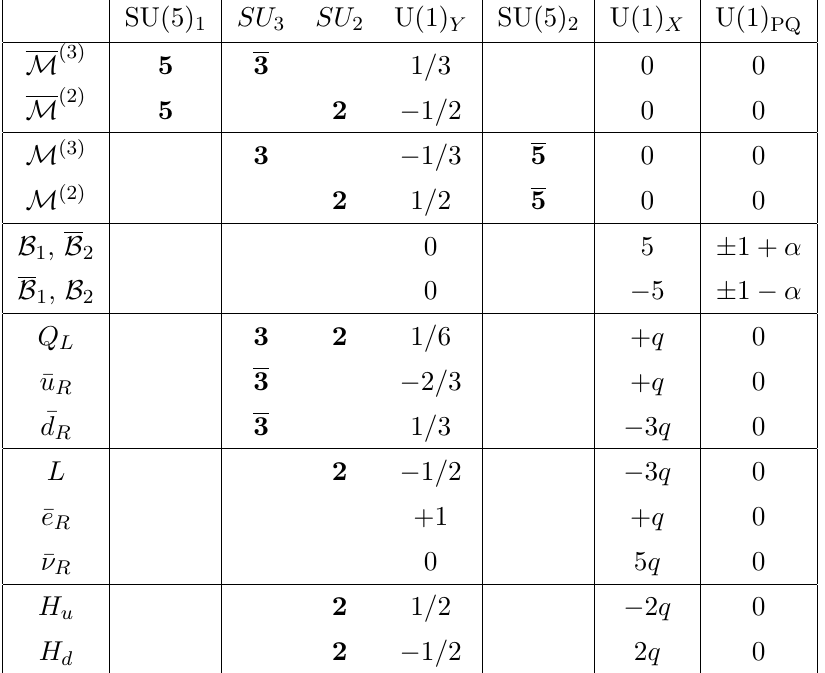
Table 3 . Charges of the matter fundamental super(cid:12)elds and Higgs doublets and composite baryons and mesons in the \5/-3/1" U(1) X